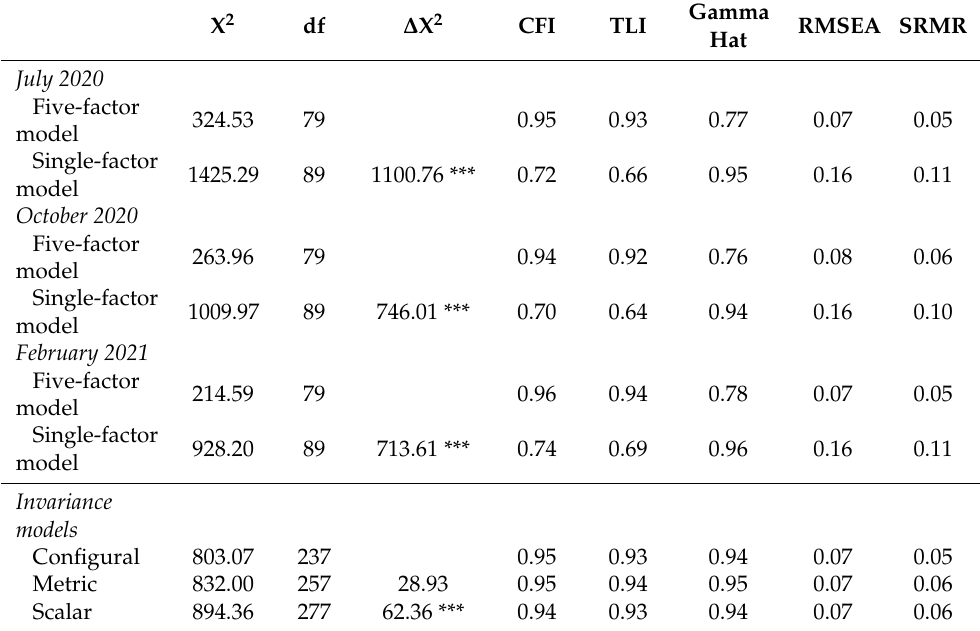
Table 2. Measurement invariance for the five-factor uncertainty model.